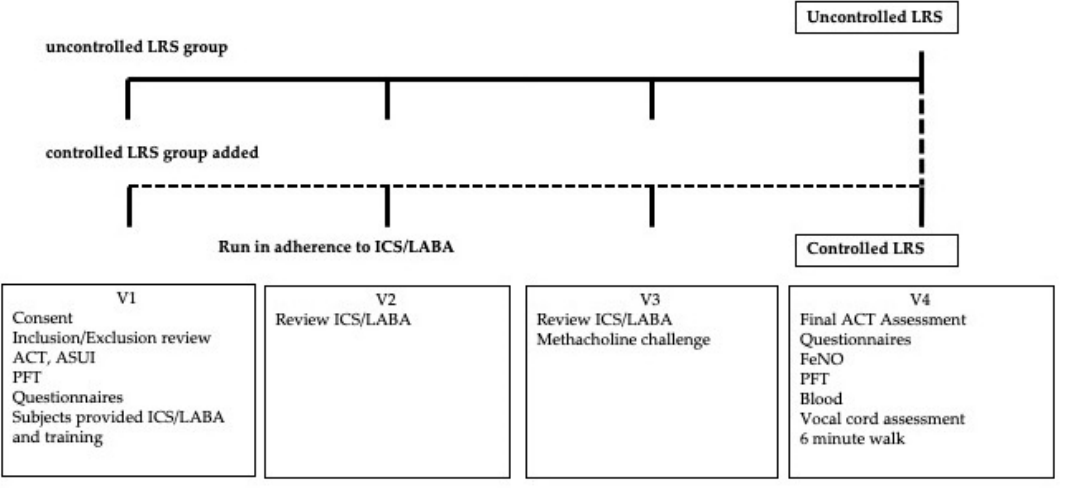
Figure 1. Protocol scheme for study design.